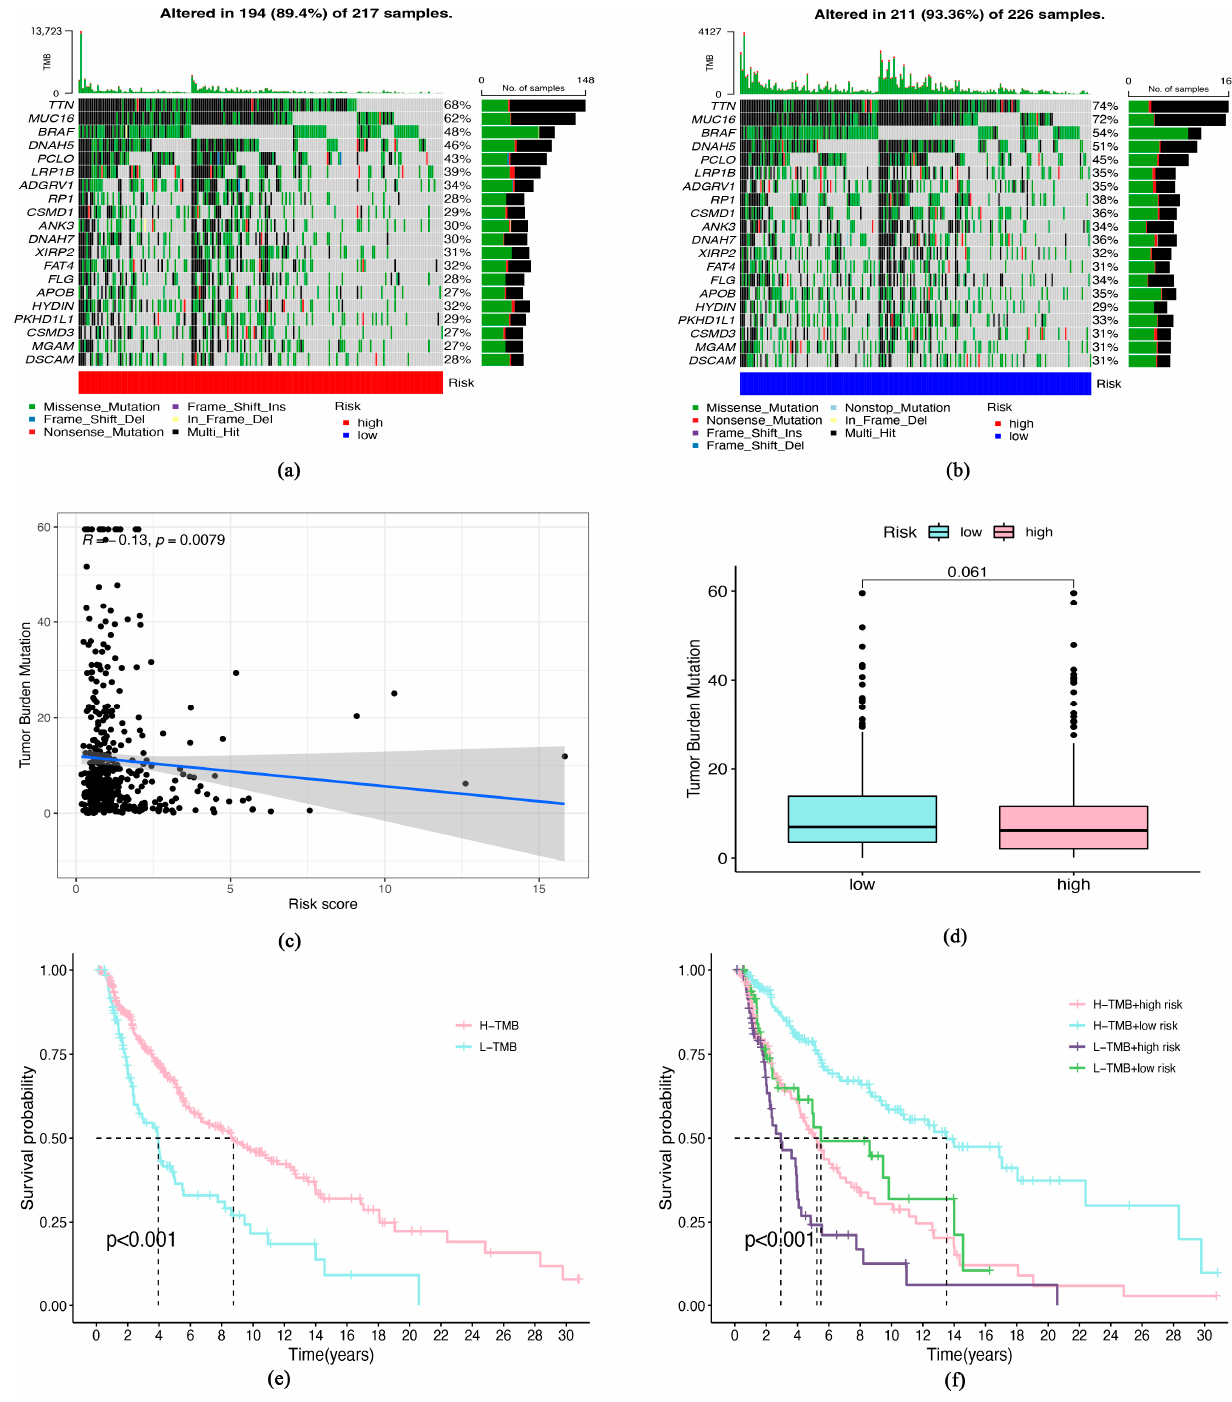
Figure 7. Risk score and tumor burden mutation. ( a , b ) The top 20 mutated genes of skin cutaneous melanoma in both risk groups. ( c ) Analysis of the correlation between risk score and TMB. ( d ) Difference between risk score and TMB. ( e ) Kaplan–Meier curves analysis for the differential TMB groups. ( f ) Kaplan–Meier curves for patients clustered by TMB and risk score.